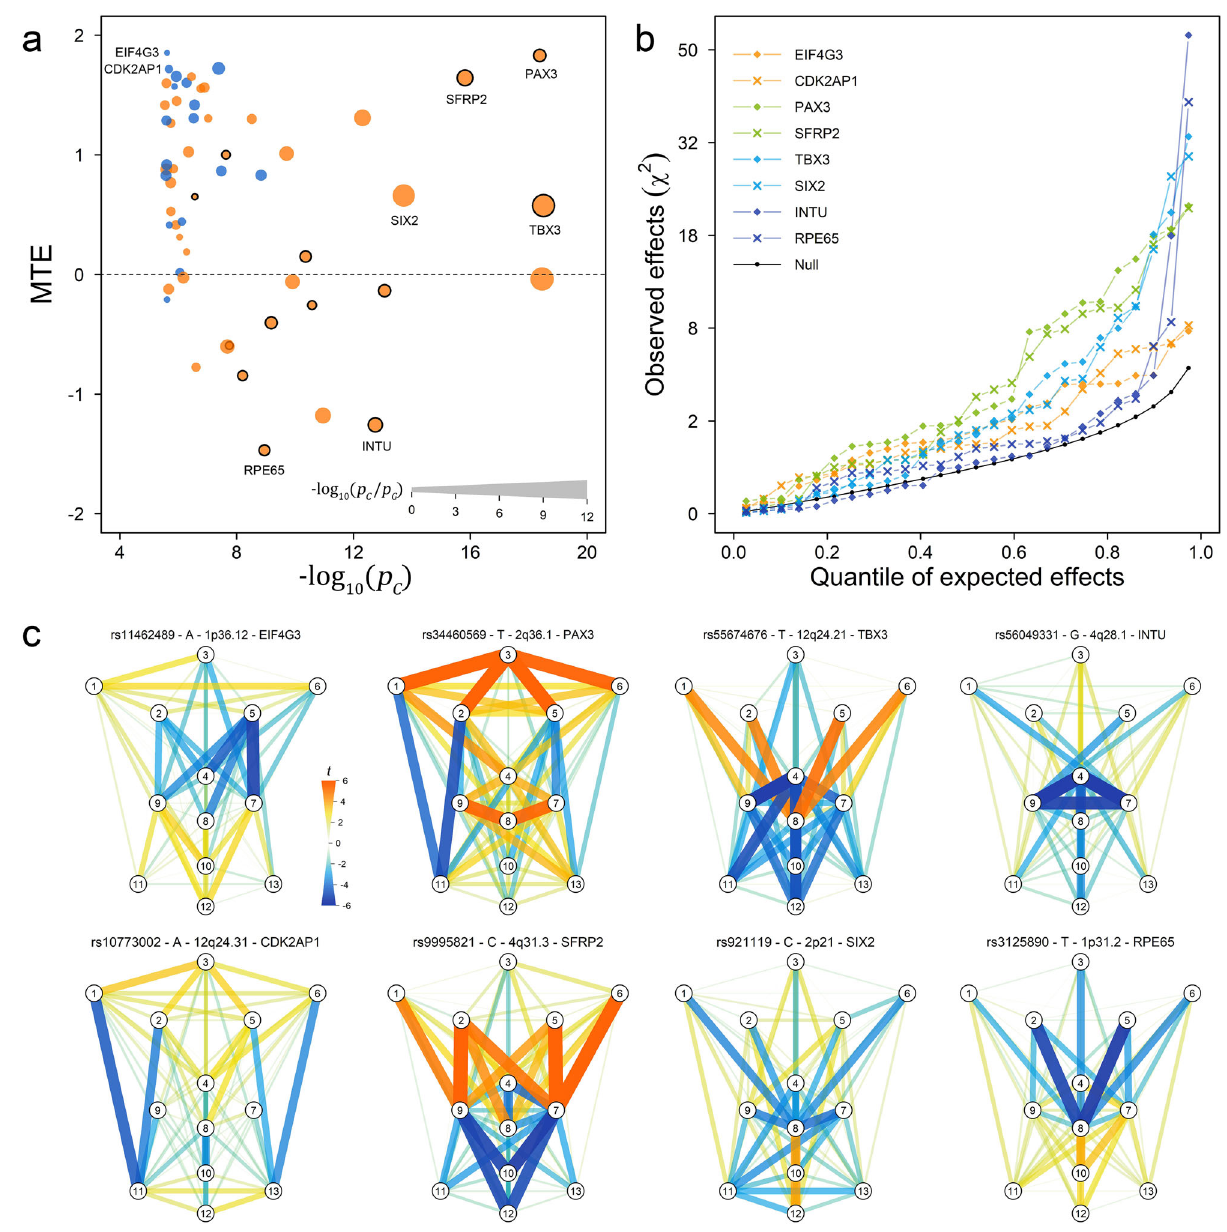
Fig. 5 | Multi-trait effects of the face-associated SNPs with examples. The esti- mated multi-trait effect (MTE, y -axis) of the 57 C-GWAS-identi fi ed study-wide sug- gestively signi fi cant regional lead SNPs were plotted against their − log 10 ( p ) from C-GWAS ( (cid:2) log 10 ð p C Þ , x -axis, a ). SNPs are indexed according to their closest genes for illustrative purpose. SNPs are distinguished with two colors of orange for pre- vious known face-associated loci and blue for novel loci. The boost of signi fi cance of C-GWASin relative to MinGWAS( (cid:2) log 10 ð p C = p G Þ ) is indicated using the dot size. TheSNPsthataresuggestivelysigni fi cantinbothC-GWASandGWASareindicated using circles with solid lines. The squared projected effects ( χ 2 ) are plotted against